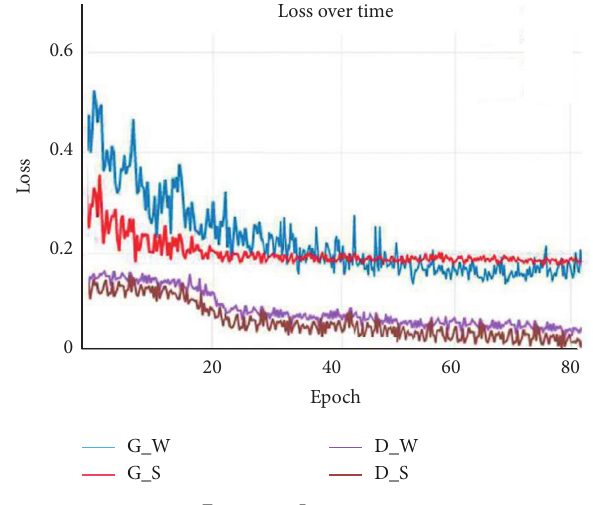
Figure 5: Loss curve.